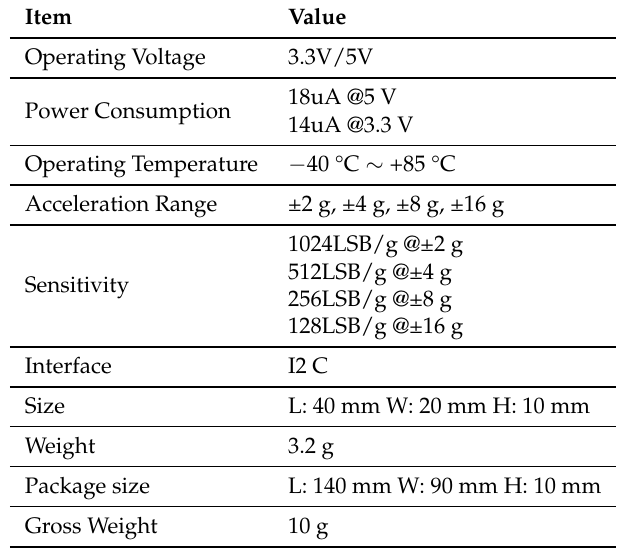
Table 1. Specification of the Grove 3 Axis Digital Accelerometer Sensor.